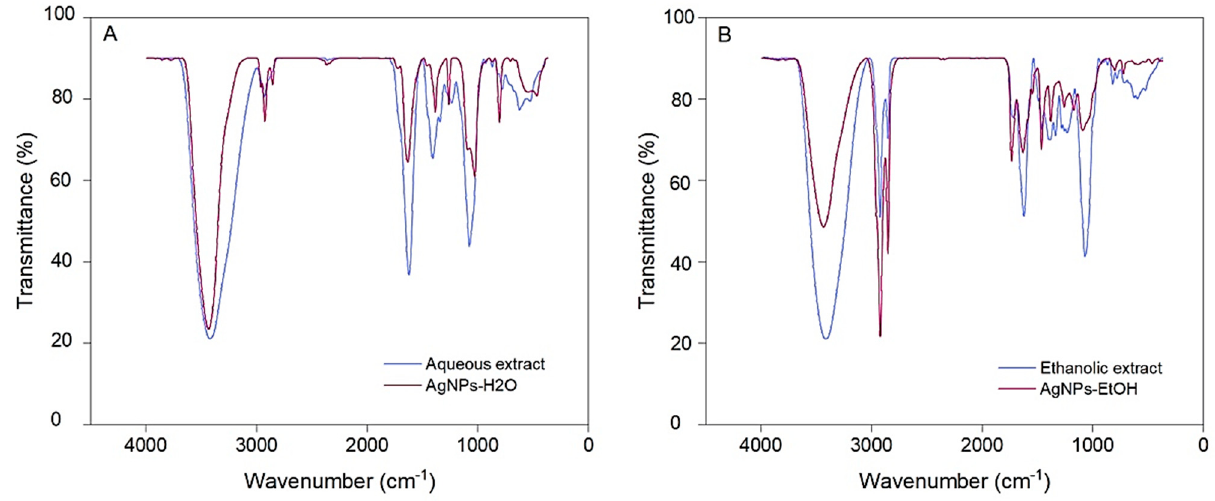
Figure 11. Comparative FTIR spectra of initial extracts and of their derived nanoparticles: AgNPs- H 2 O (A) and AgNPs-EtOH (B).